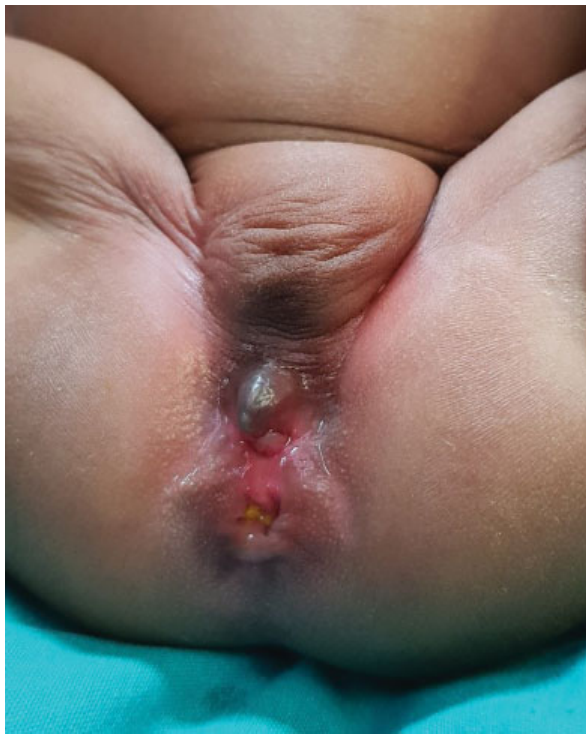
Fig. 3 Intraoperative image: posterior sagittal anorectoplasty and total urogenital mobilization. European Journal of Pediatric Surgery Reports Vol. 9 No. 1/2021 © 2021. The